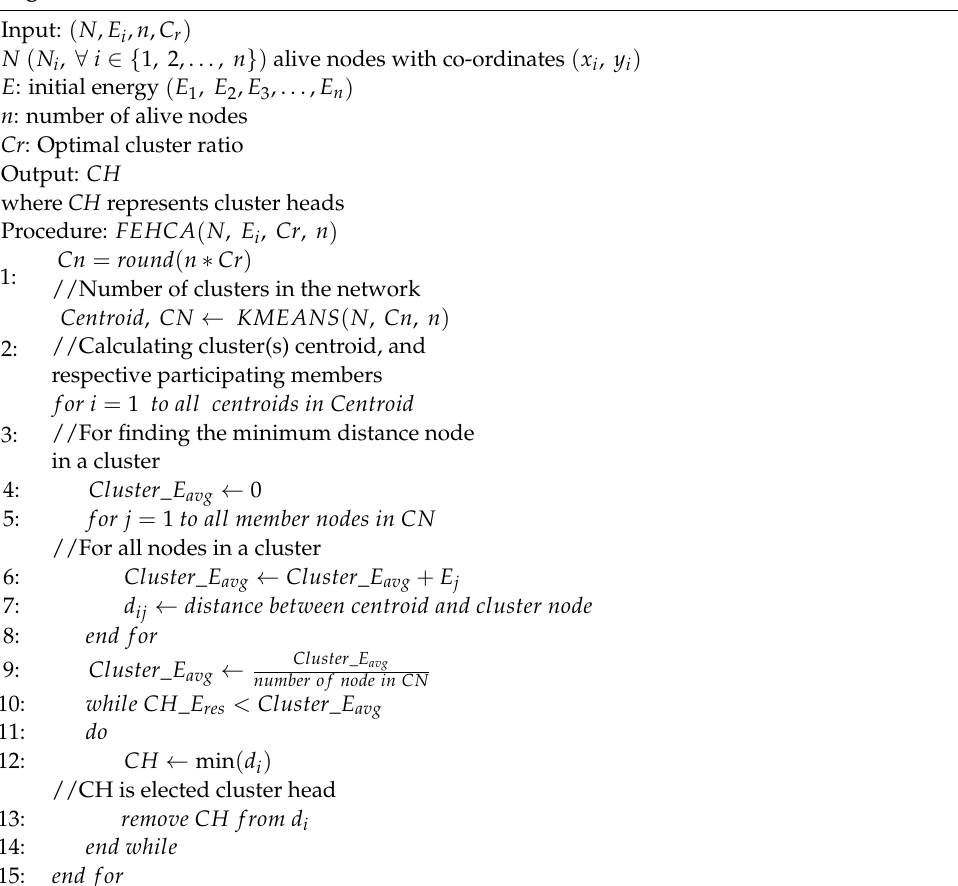
Algorithm 1. Cluster head election in